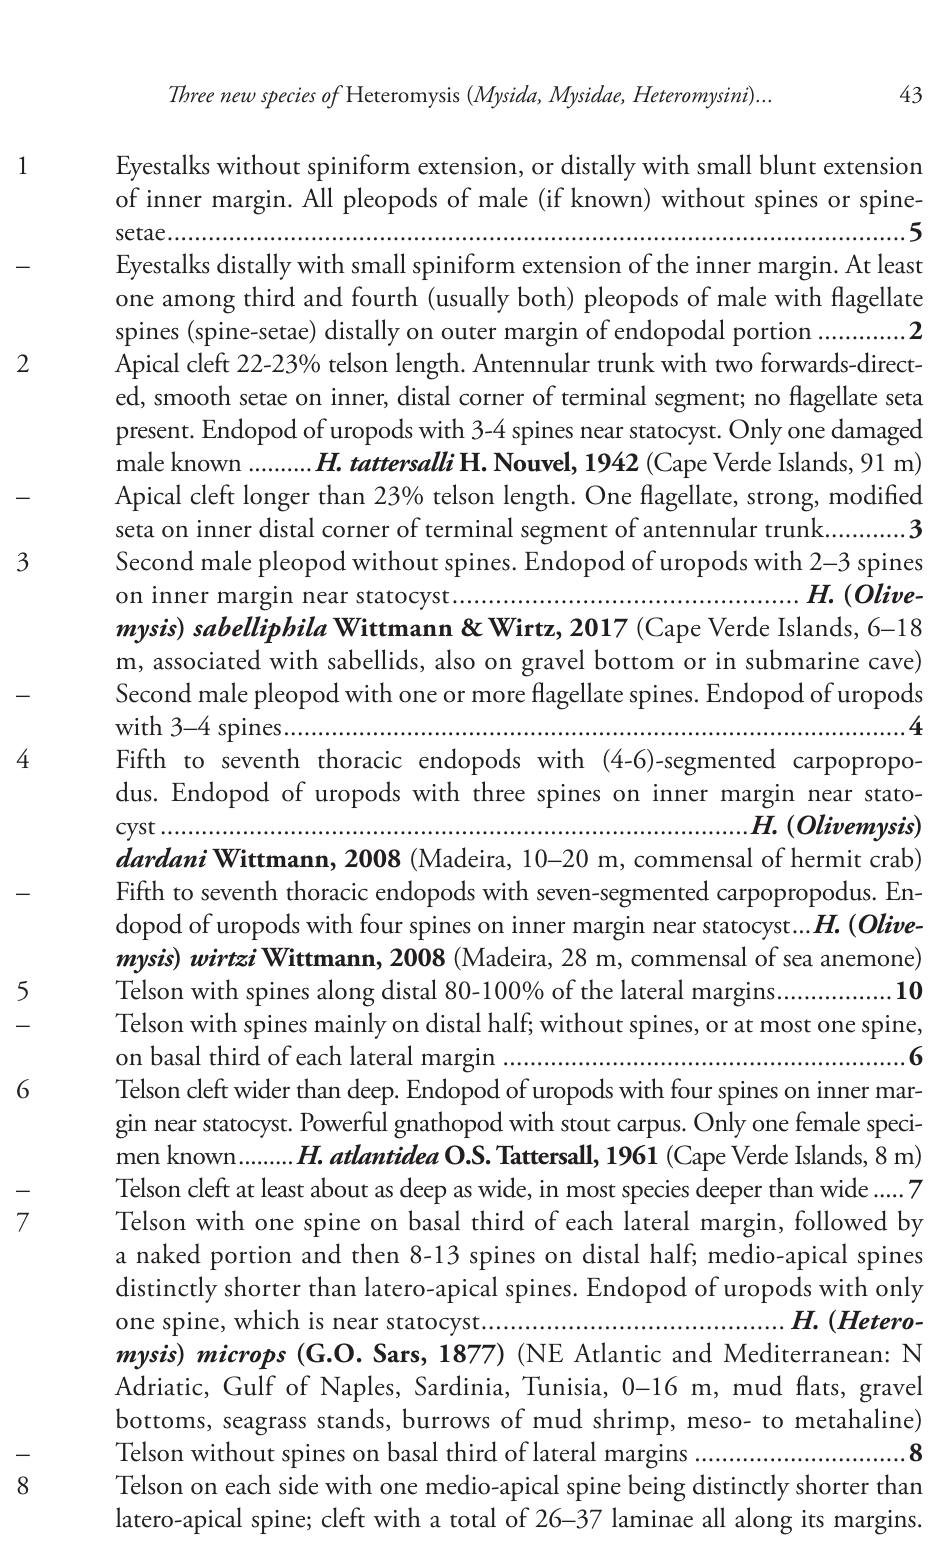
Telson on each side with one medio-apical spine being distinctly shorter than latero-apical spine; cleft with a total of 26–37 laminae all along its